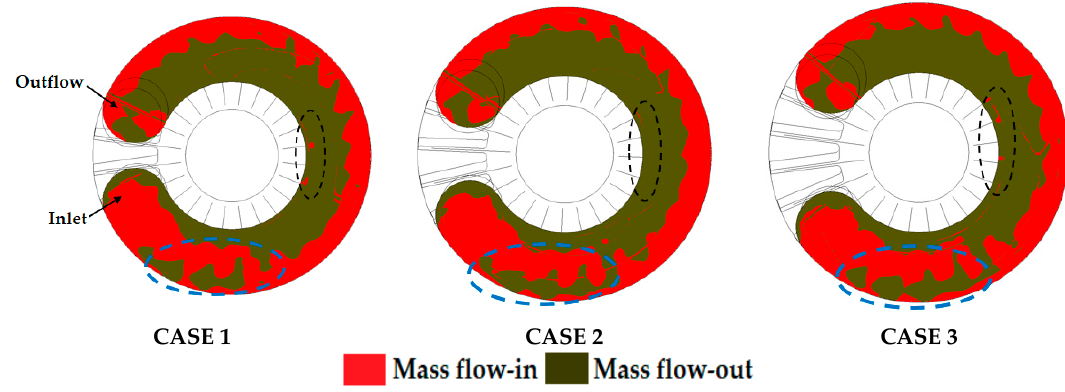
Figure 5. Exchanged mass flow plot between the impeller and side channel of three cases. Table 4. Exchanged mass flow.